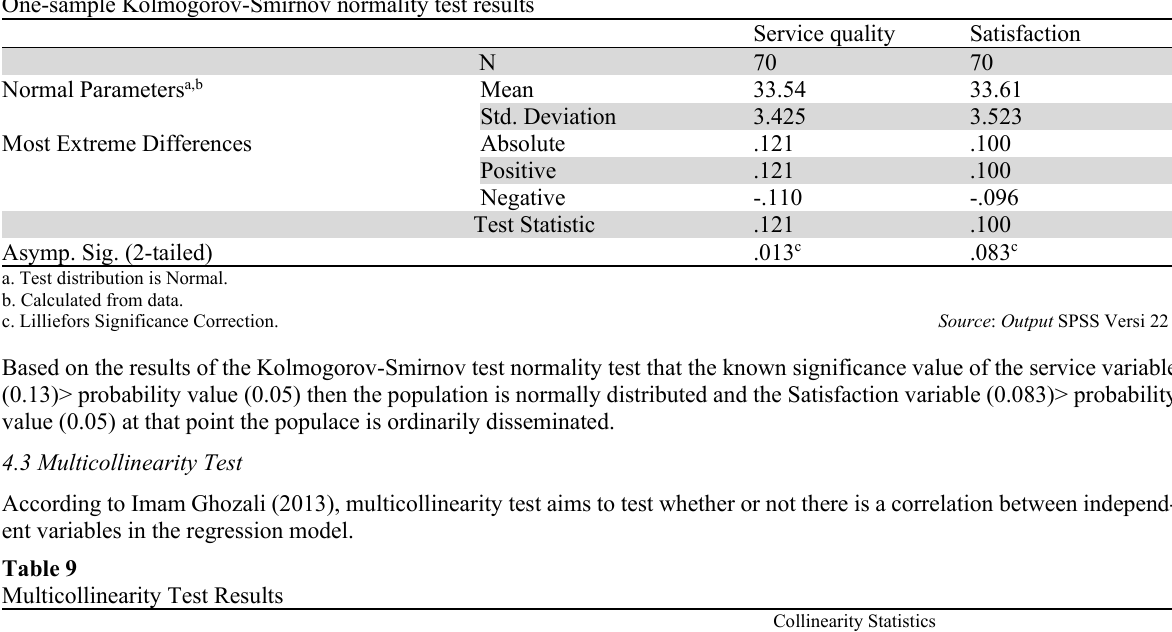
One-sample Kolmogorov-Smirnov normality test results